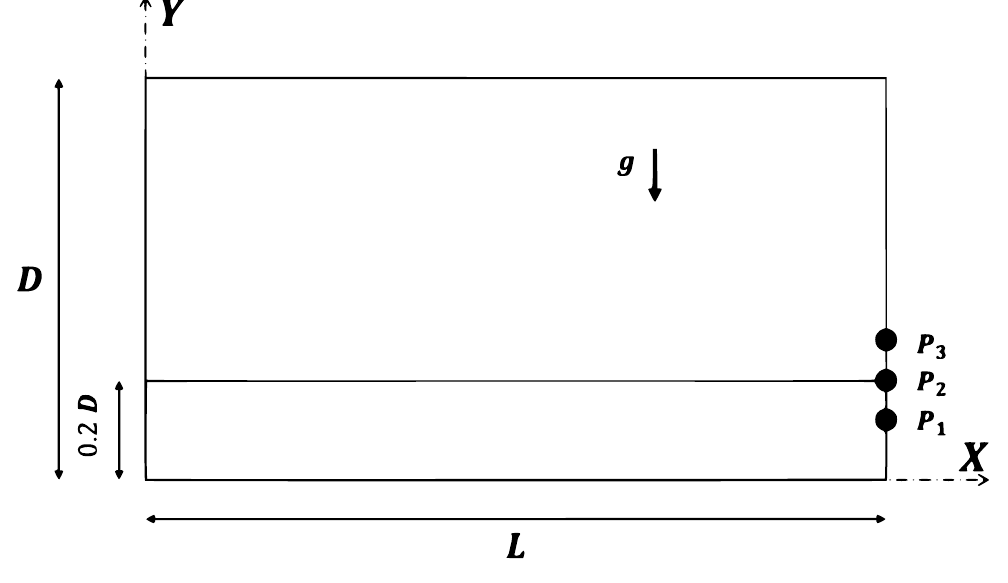
Figure 27. Sloshing in a rectangular tank: initial